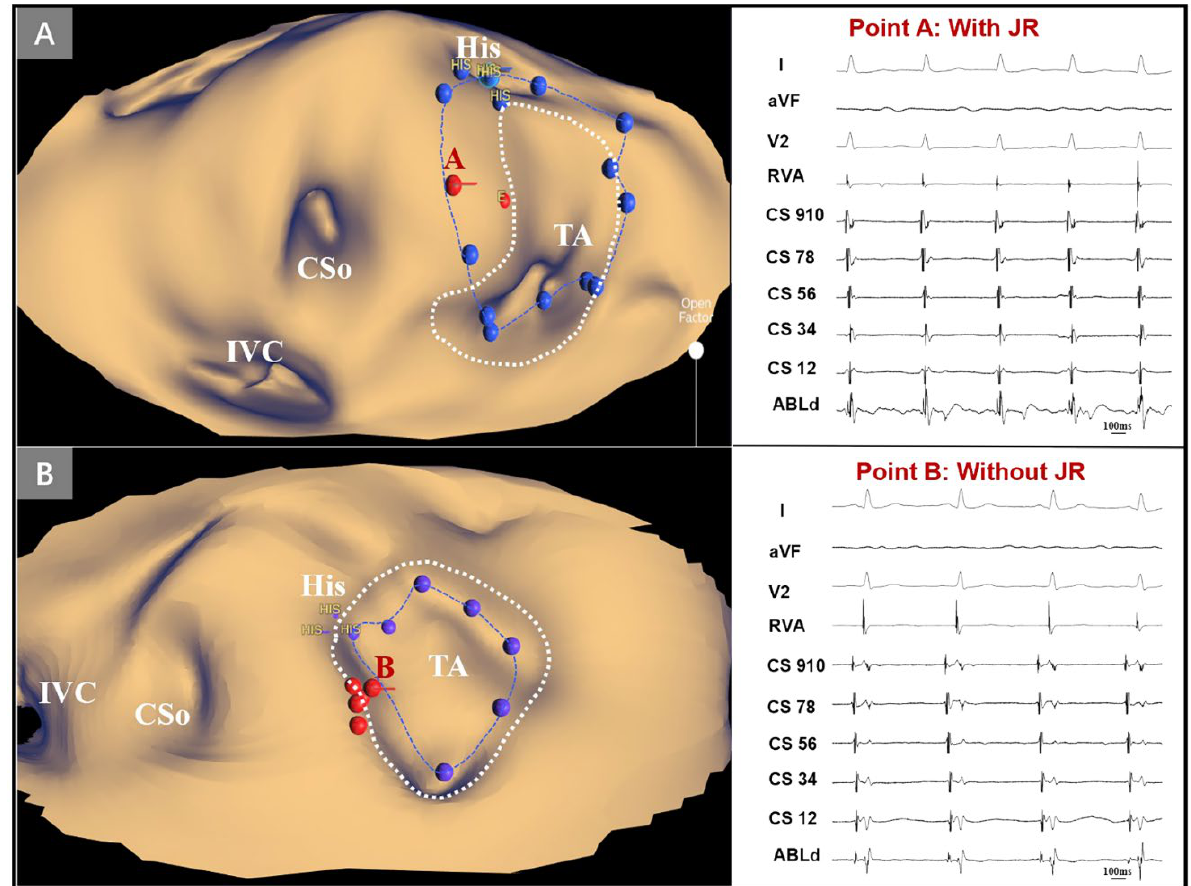
Figure 4. Retrospective analysis of two patients with AVNRT in PANO View. ( A , B ) Target distribu- tions in PANO View. The dotted line in blue and purple represents the tricuspid annulus determined by electrograms, and the dotted line in white represents the tricuspid annulus determined by KODEX- EPD 3D reconstruction. Points A and B both represent the ablation points. Point A was located in the aSP region and exhibited the appropriate JR during ablation, while point B was located in the nonaSP region and did not exhibit JR during the whole RFCA delivery. CSo = coronary sinus ostium; His = His bundle potential; IVC = inferior vena cava; JR = junctional rhythm; PANO View = Panoramic